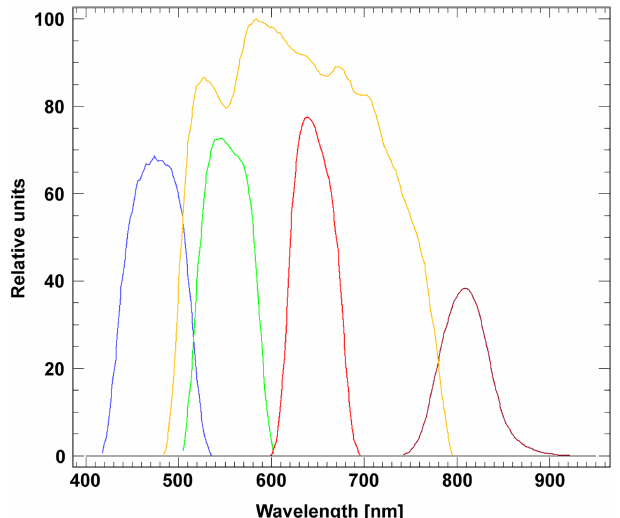
Figure B2. Spectral response of HRSC-AX panchromatic color fil-